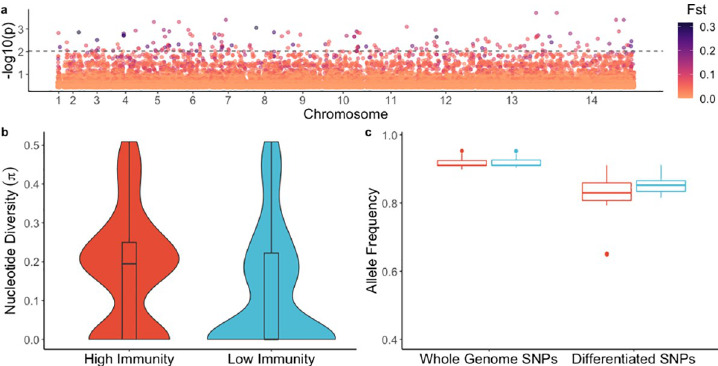
Fig 2. Genetic differentiation between parasites from high immunity vs . low immunity groups. a) Genome-wide genetic differentiation ( F ST ) between parasites from individuals with higher immunity vs . lower immunity. Each point represents a variable, non-synonymous site. Results are plotted as–log 10 p -values on the y-axis. The color of each point represents the F ST value, with darker points indicating higher F ST values. The dashed line denotes statistical significance ( p- value = 0.0095), with p -value determined by permutation. b) Nucleotide diversity for significantly differentiated SNPs in parasites from individuals with higher immunity and lower immunity. c) Box-plot of mean allele frequency per individual based on SNPs in the whole genome sequences, and which are significantly differentiated SNPs from (a). Red indicates the high immunity group and blue color indicates the low immunity group.